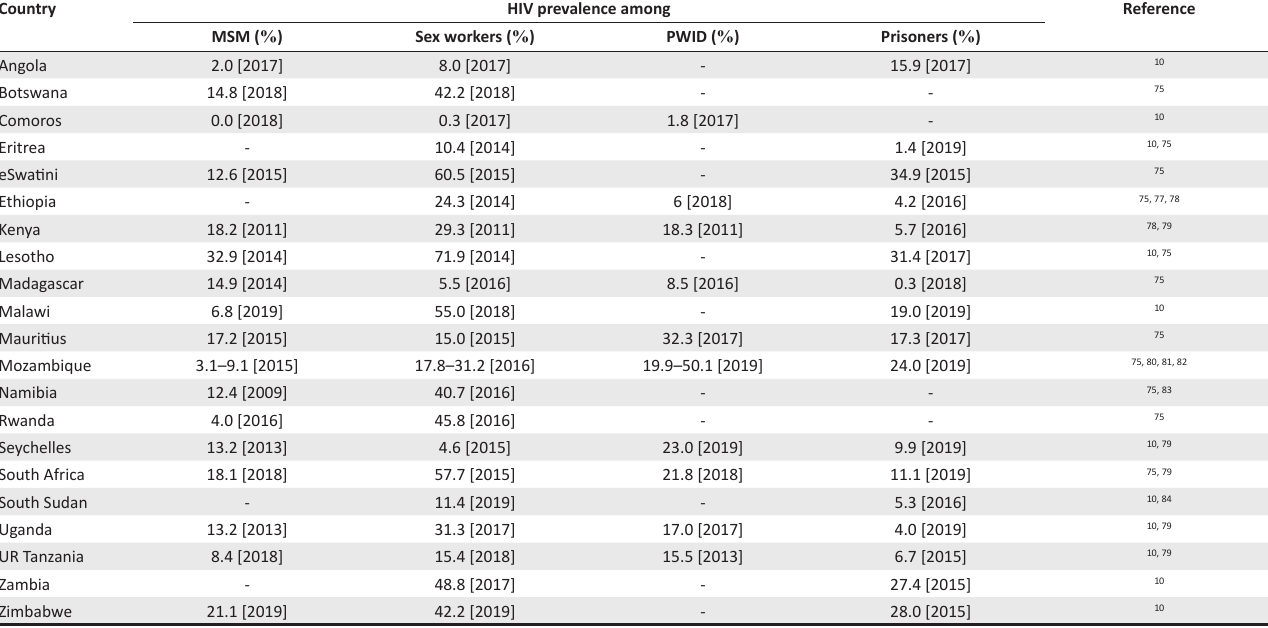
TABLE 1: Prevalence of HIV among certain key and vulnerable populations in ESA.